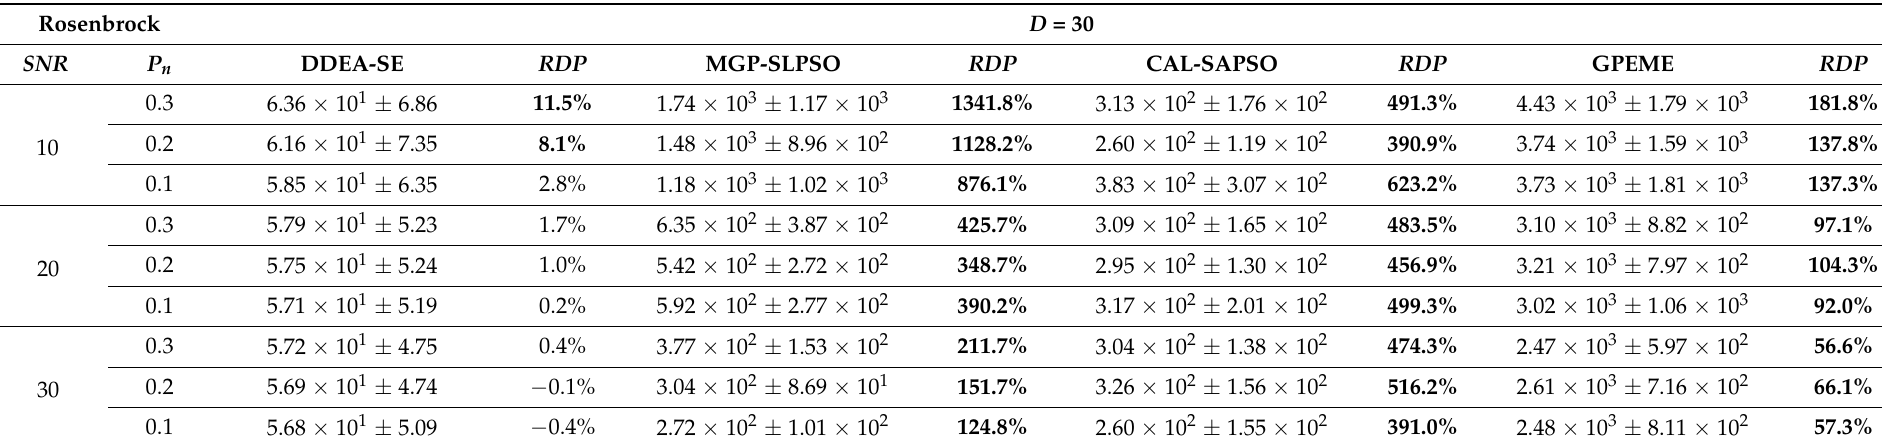
Table A4. Experimental results (with standard deviation) and RDP of DDEAs on 30-dimensional Rosenbrock